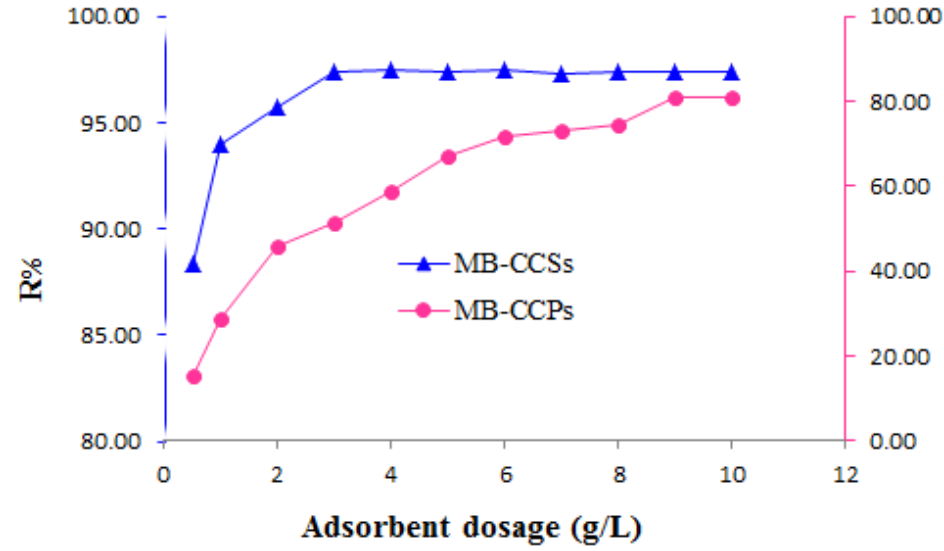
Figure 6. Effect of adsorbent dosage on MB removal efficiency using CCSs and CCPs.